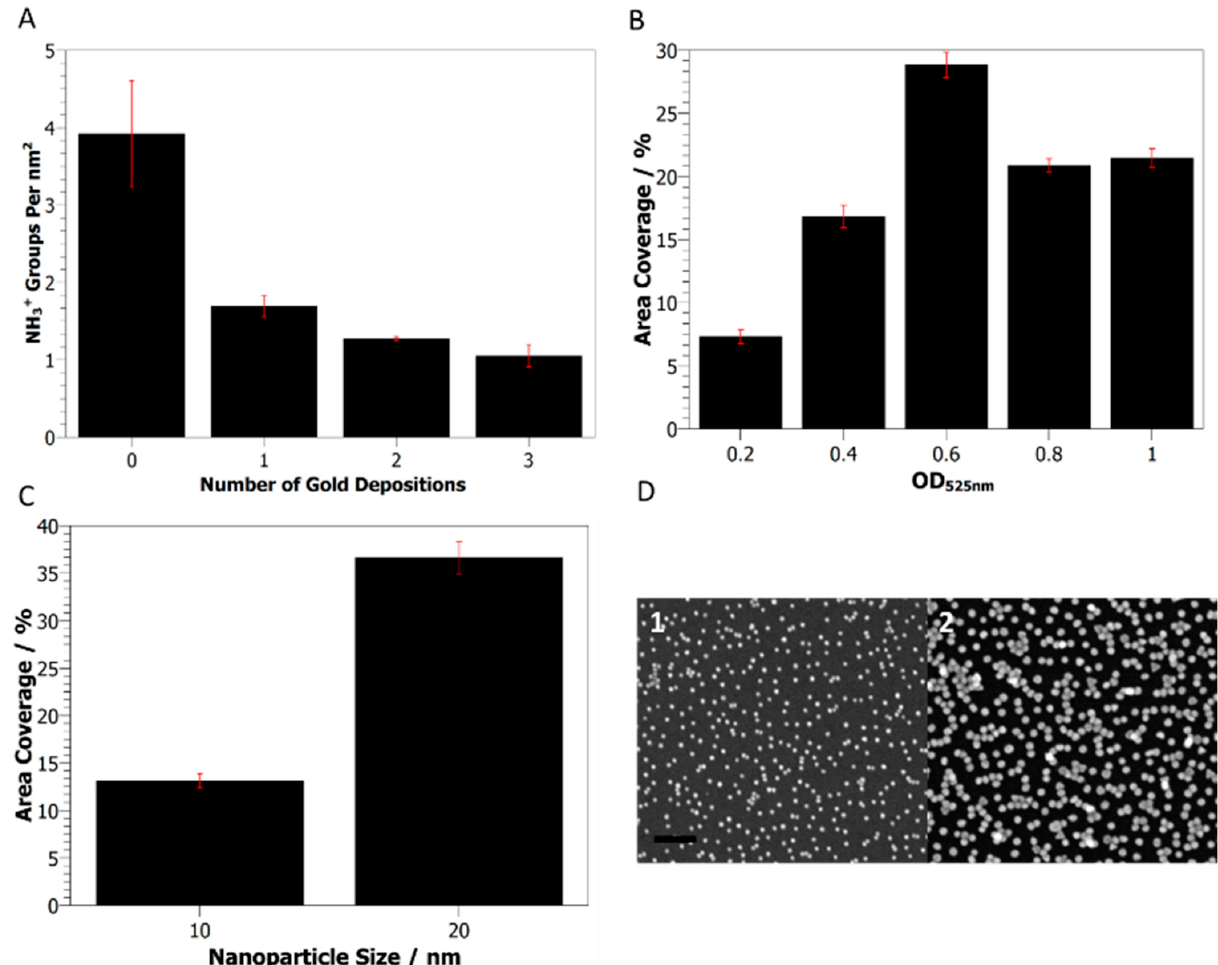
Figure 2. Gold nanoparticle deposition on AAPTMS functionalized silicon wafers. ( A ) The density of primary amine moieties on the wafer surface after multiple 10 nm gold nanoparticle depositions. ( B ) Area coverage of 10 nm gold nanoparticles on the surface after deposition with increasing nanoparticle concentration. ( C ) E ff ect of nanoparticle size on surface coverage. ( D ) Representative SEM images of deposited 10 nm (1) and 20 nm (2) gold nanoparticle surfaces. Scale bar = 100 nm .